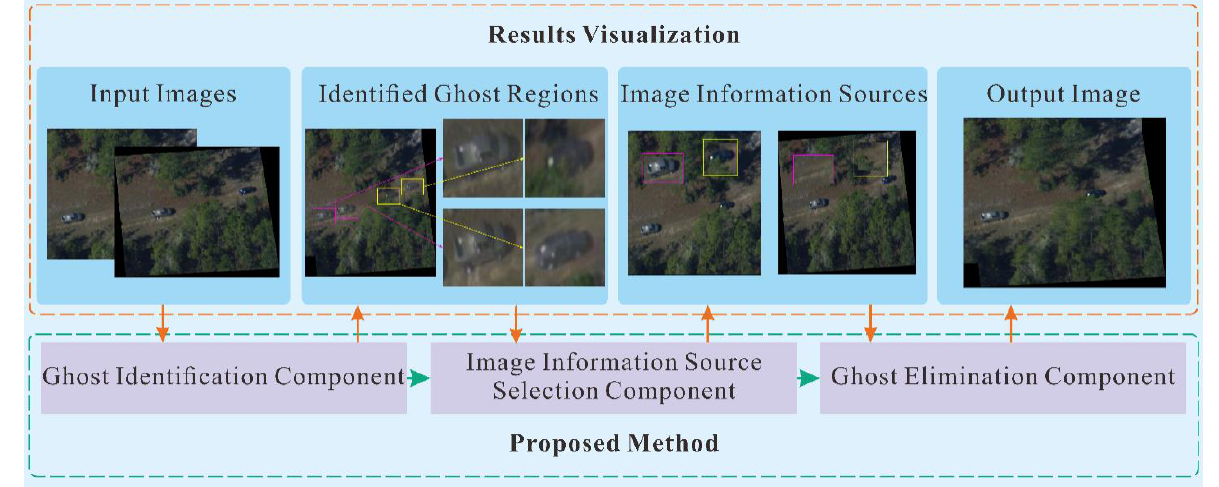
Figure 1. The collaboration flow of the three components.